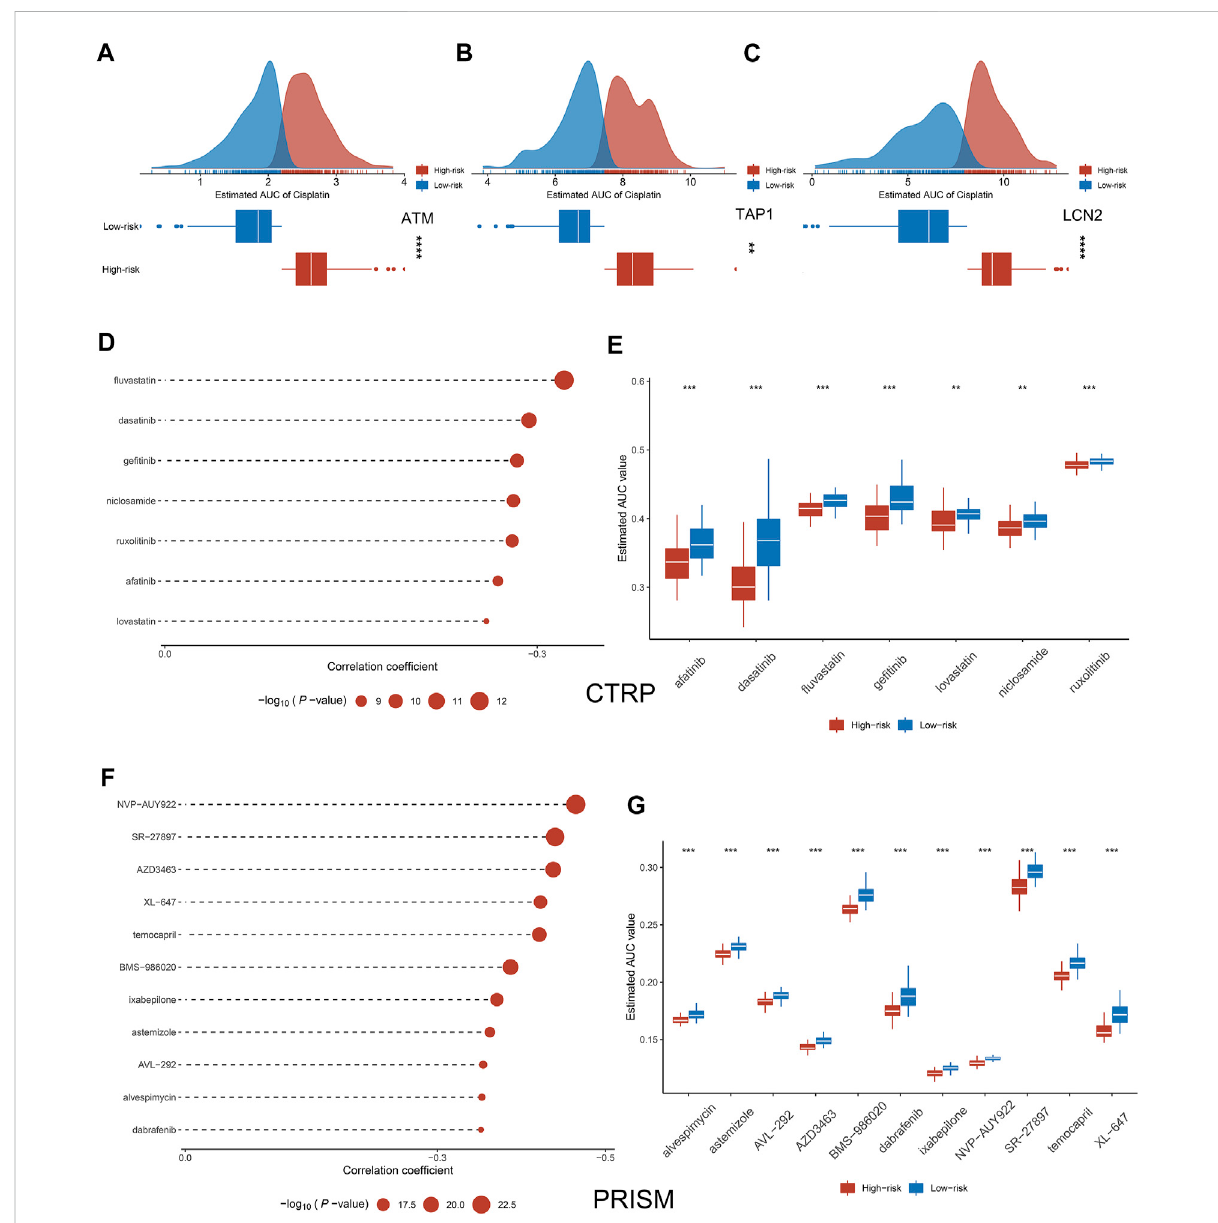
FIGURE 8 Exploration of potential therapeutic drugs. (A – C) Comparison of sensitivity to cisplatin in high and low groups of ATM (A) , TAP1 (B) , and LCN2 (C) . (D – G) Drugs sensitive to high-risk group cell lines were identi fi ed from CTRP and PRISM. * p < 0.05, ** p < 0.01, *** p < 0.001, **** p <